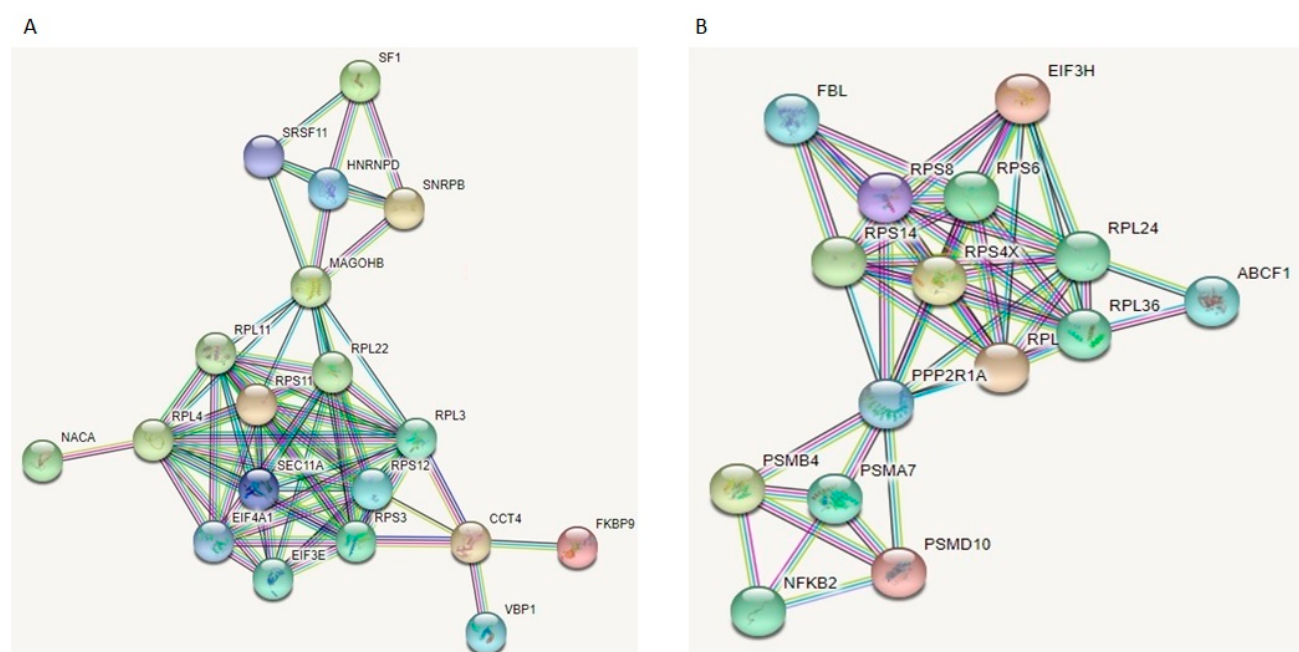
Figure 9. STRING analysis of DE proteins identified in chondrocytes treated with miR-143-3p mimic, inhibitor or control following LC-MS/MS. DE proteins ( p < 0.05) between ( A ) mimic vs. control group and ( B ) inhibitor vs. control group, were uploaded on STRING for protein network analysis and to identify protein–protein interactions. Filters were set to show both functional and physical protein associations, and highest confidence (0.900) was selected. Line colour indicates the type of interaction evidence. Stronger associations are represented by thicker lines. Figure generated with STRING.